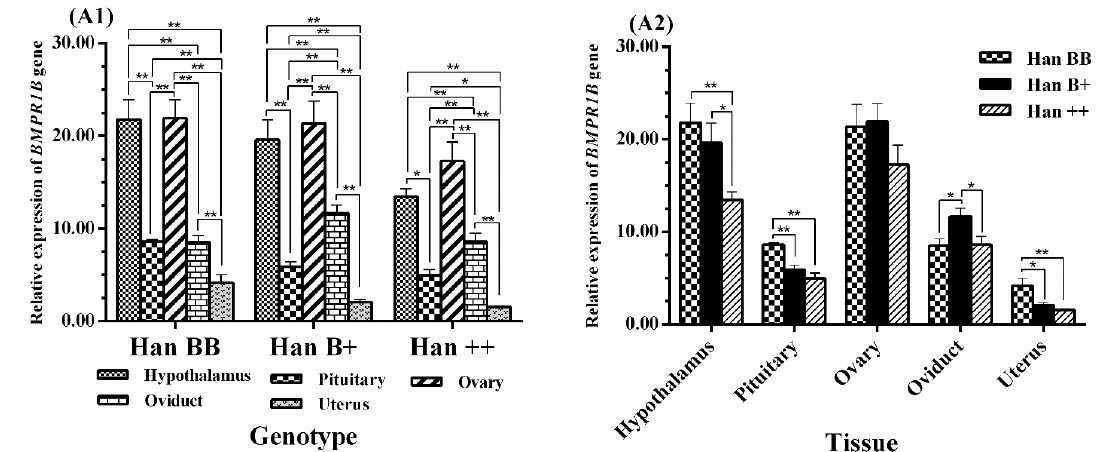
Figure 3. Comparison of expression of BMPR1B among three FecB genotypes ( A1 ) and among tissues ( A2 ). Means with different superscripts are significantly different. The significant results with a p -value lower than 0.01, 0.05 are giving two asterisks (**) and one asterisk (*), respectively. Nonsignificant results are not giving any asterisks.